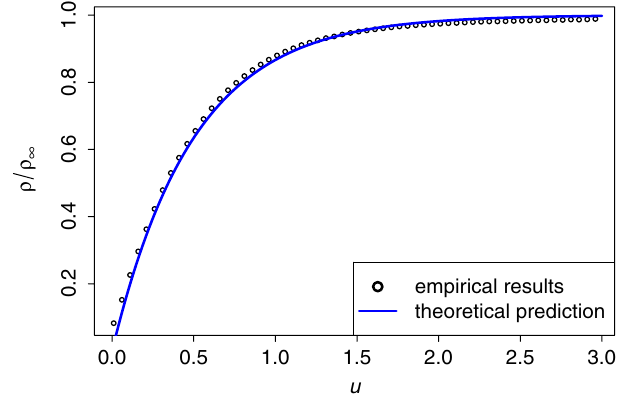
FIG. 2. Map of diffusivity in the plane (cid:10); (cid:11) for (cid:4) ¼ 0 : 5 , (cid:8) ¼ ¼ 10 (cid:2) 4 . The large (cid:10) , large (cid:11) region corresponds to 0 : 1 , (cid:5) 1 subdiffusion, while the small (cid:10) , small (cid:11) region corresponds to superdiffusion. The efficient market (diffusive) line determined numerically is such that (cid:11) ð 0 : 8 Þ (cid:1) 0 : 65 , (cid:11) ð 0 : 5 Þ (cid:1) 0 : 95 , and (cid:11) ð 0 : 3 Þ (cid:1) 2 : 5 (crosses). Note that the unit volume limit (cid:11) ! 1 corresponds to (cid:10) ! 0 . Without volume fluctuations, deep and slow markets are therefore always found to be in the subdiffusive phase.